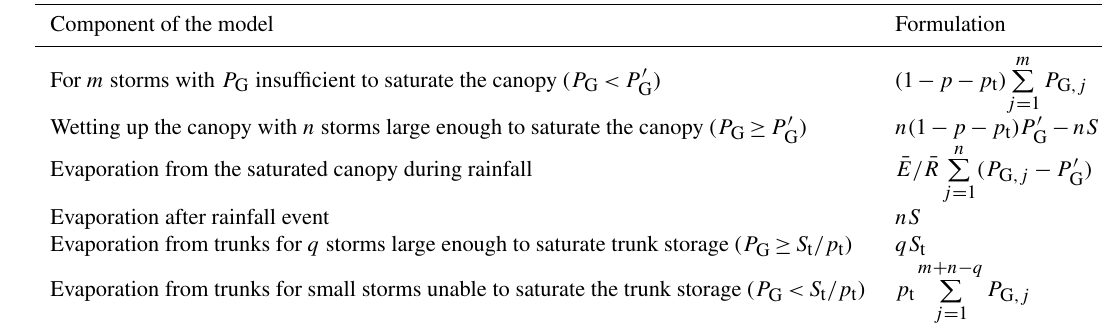
Table 3. Main equations of the analytical Gash (1979) interception model. Component of the model